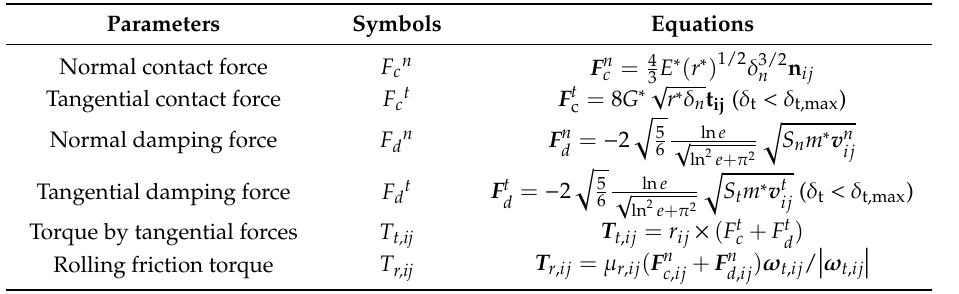
Table 1. Forces and torques contained among particles i and j